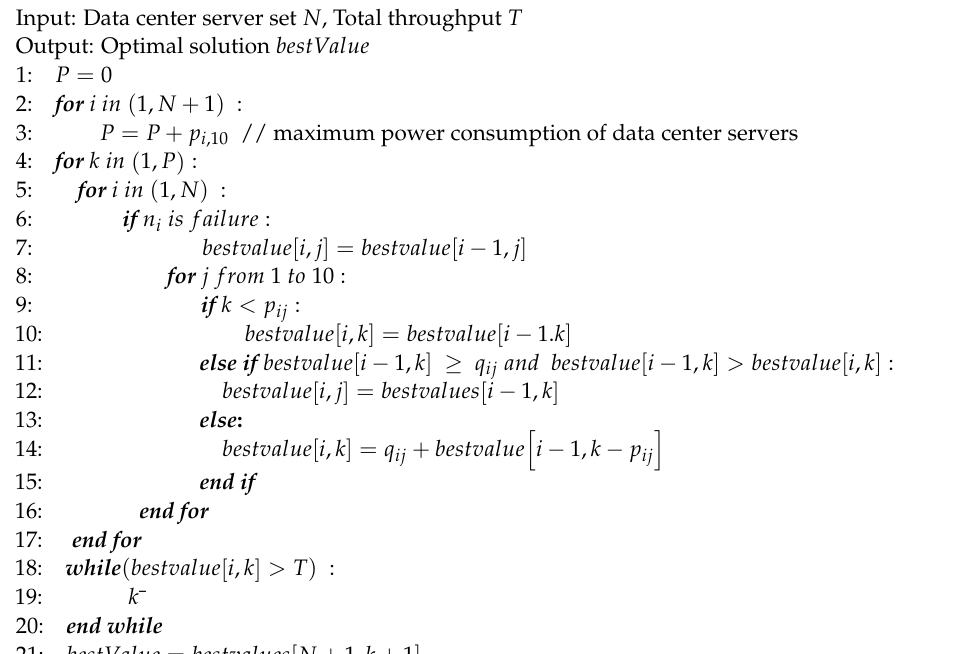
Algorithm 2: Minimizing total power consumption simulation algorithm